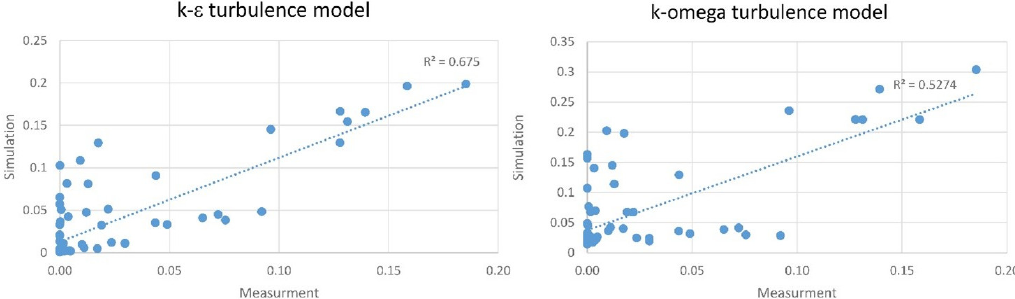
Figure 4. Simulated velocities plotted against corresponding measurements for two different turbulence